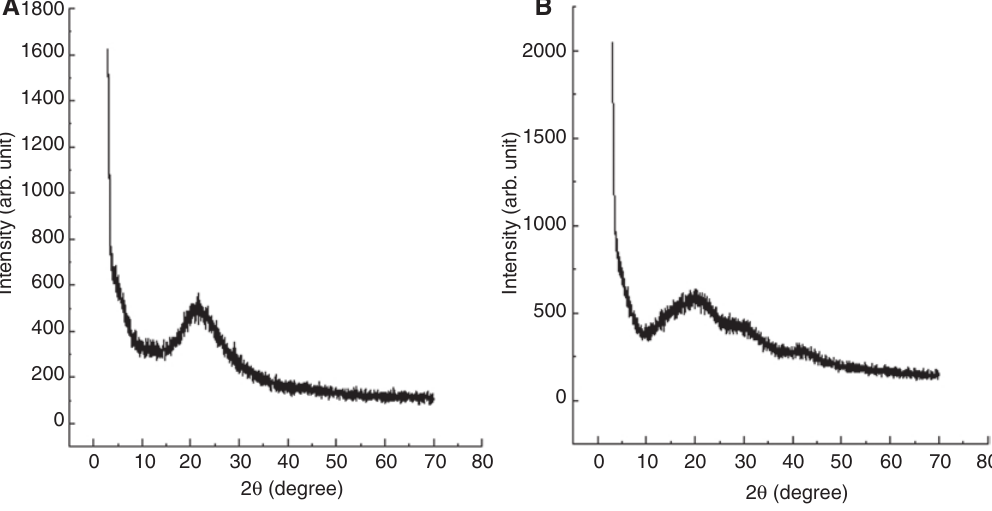
Figure 3 XRD pattern of nanosilica. (A) Unmodified. (B) Modified with